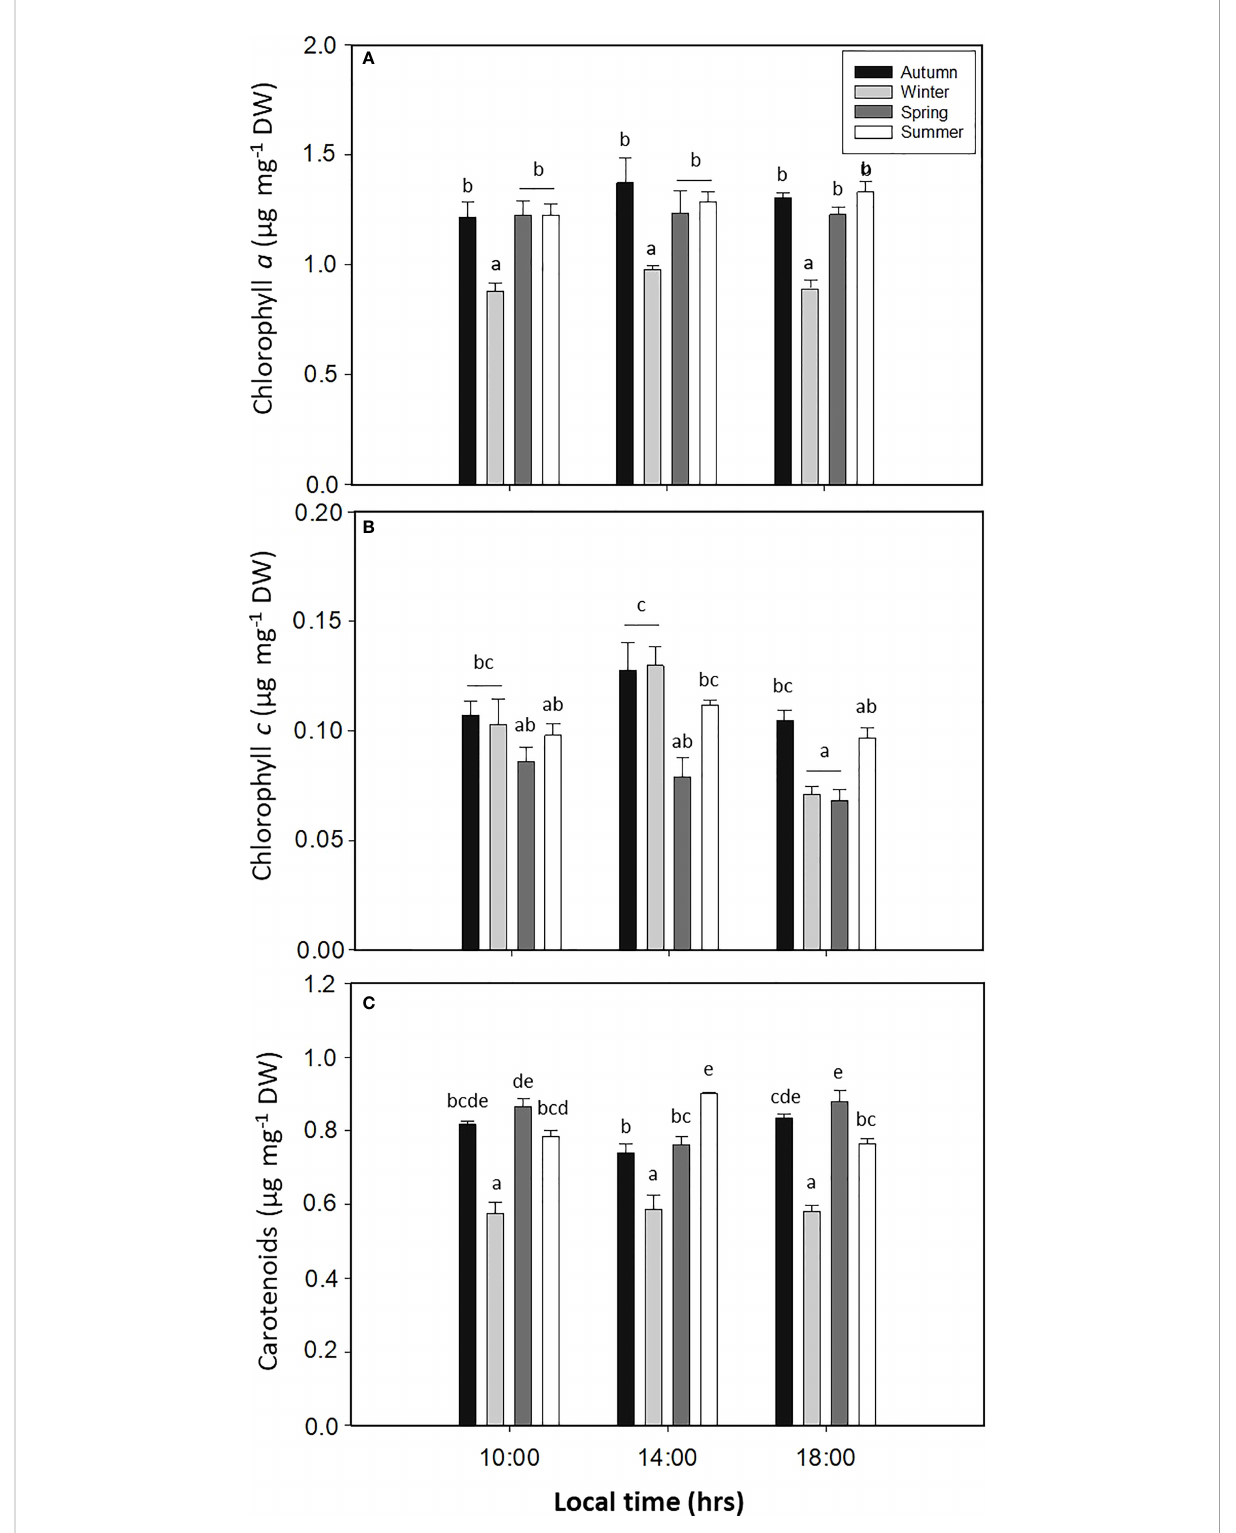
FIGURE 6 (A) Chlorophyll a , (B) chlorophyll c , and (C) total carotenoids in Lessonia spicata under daily cycle experiments in autumn, winter, spring, and summer between 2019 and 2020 in Valpara ı ́ so Bay. Lower - case letters denote signi fi cant after the SNK